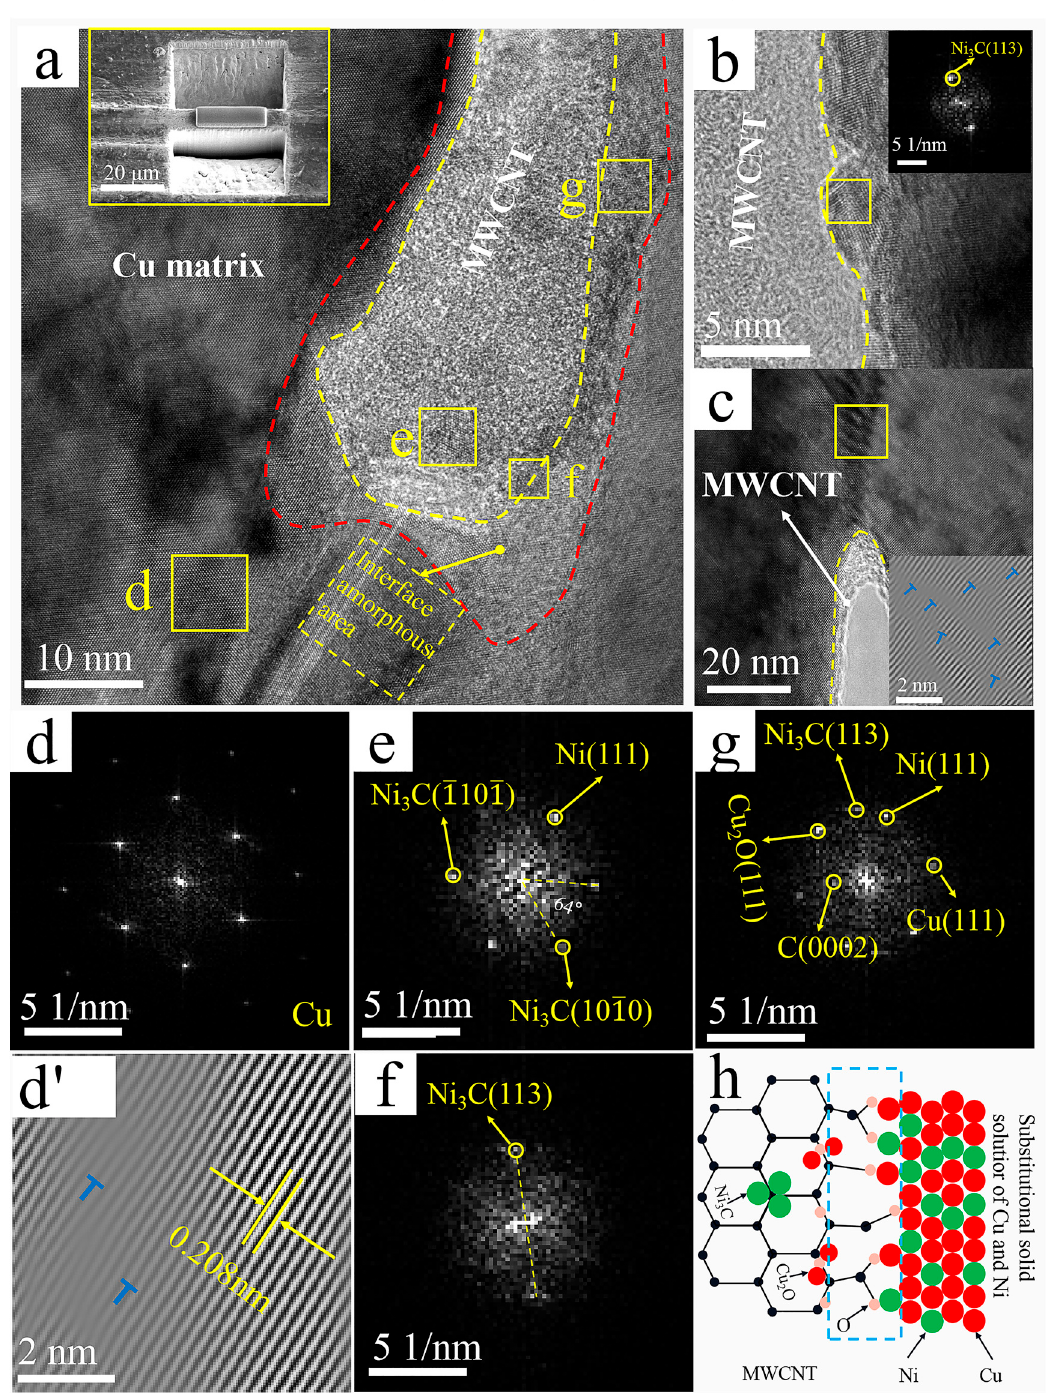
Figure 7. TEM images of the Ni@CNTs/Cu composite: ( a ) interface, top left inset shows manipulator sampling (Illustration is TEM sampling location); ( b ) Interface between MWCNT and Cu (Illustration is an FFT image of the yellow area); ( c ) Interface between MWCNT and Cu (Illustration is an IFFT image of the yellow area); ( d , d’ ) FFT and IFFT images of region d in a, with dislocations marked by “T” symbols; ( e – g ) FFT images of the corresponding regions in( a ); ( h ) Schematic diagram of interface formation. Similar to the Cu@CNTs/Cu composite, a 6–8-nm-thick amorphous transition zone along the sidewalls of MWCNTs was formed at the interface, as shown in the regions between the red and yellow dashed lines in Figures 7b and 8a. The Ni(111) plane, Ni 3 C(113), planar Cu(111) plane, and Cu 2 O(111) plane were identified according to the